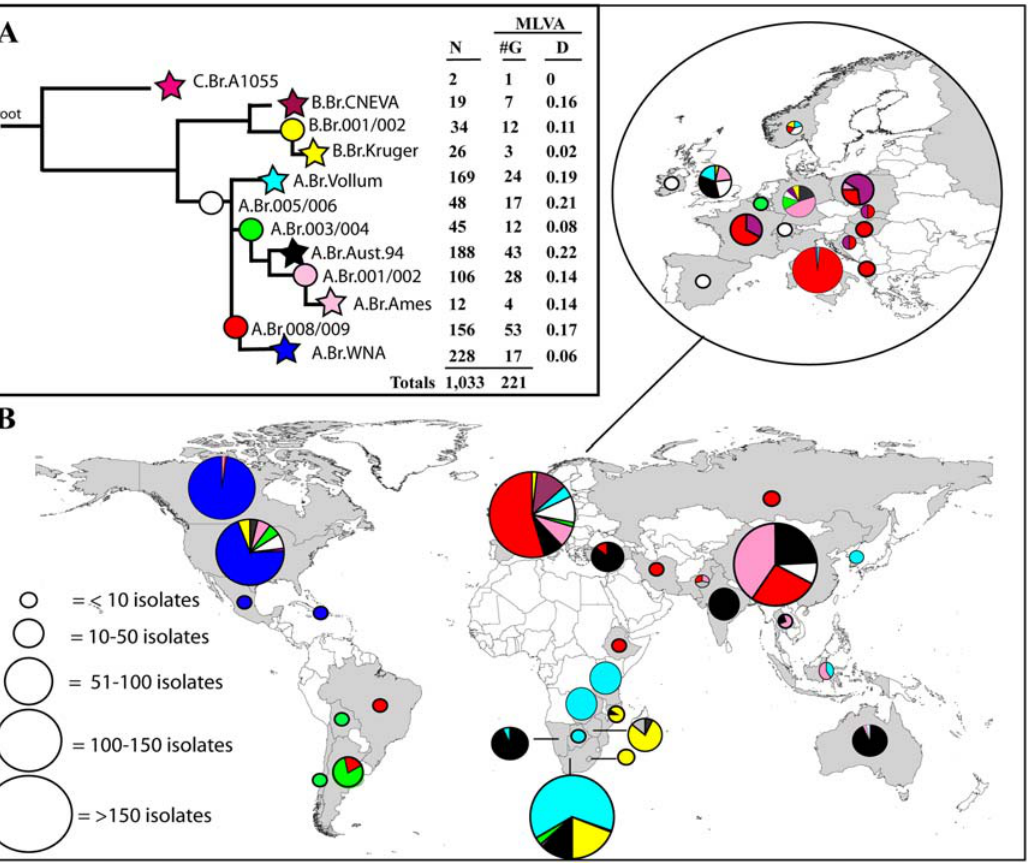
Figure 3. Worldwide distribution of B. anthracis clonal lineages:Phylogenetic and geographic relationships among 1,033 B. anthracis isolates. (A) Population structure based upon analysis of data from 12 canSNP (Protocol S1). The numbers of isolates (N) and associated MLVA genotypes (G) within each sub-lineage are indicated as well as the average Hamming distance (D) as estimated from VNTR data. The major lineages (A, B, C) are labelled, as are the derived sub-lineages (1–12), which are also color-coded. (B) Frequency and geographic distribution of the B. anthracis sub- lineages. The colors represented in the pie charts correspond to the sub-lineage color designations in panel A.